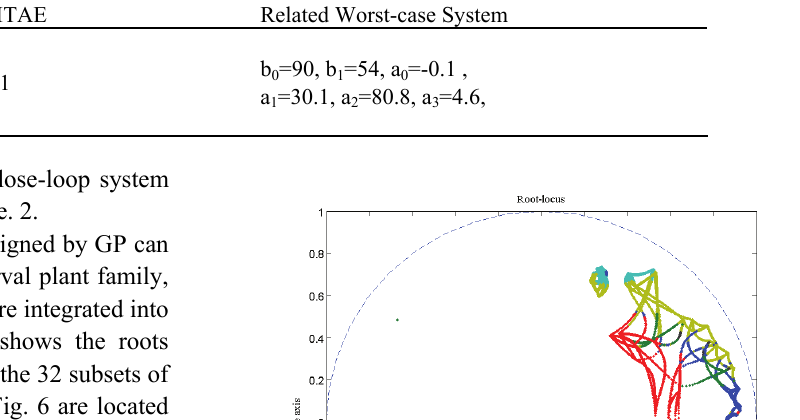
Table.2 Robust optimal controller performance and the worst-case plant related Settling Time Overshoot Max ITAE Related Worst-case System